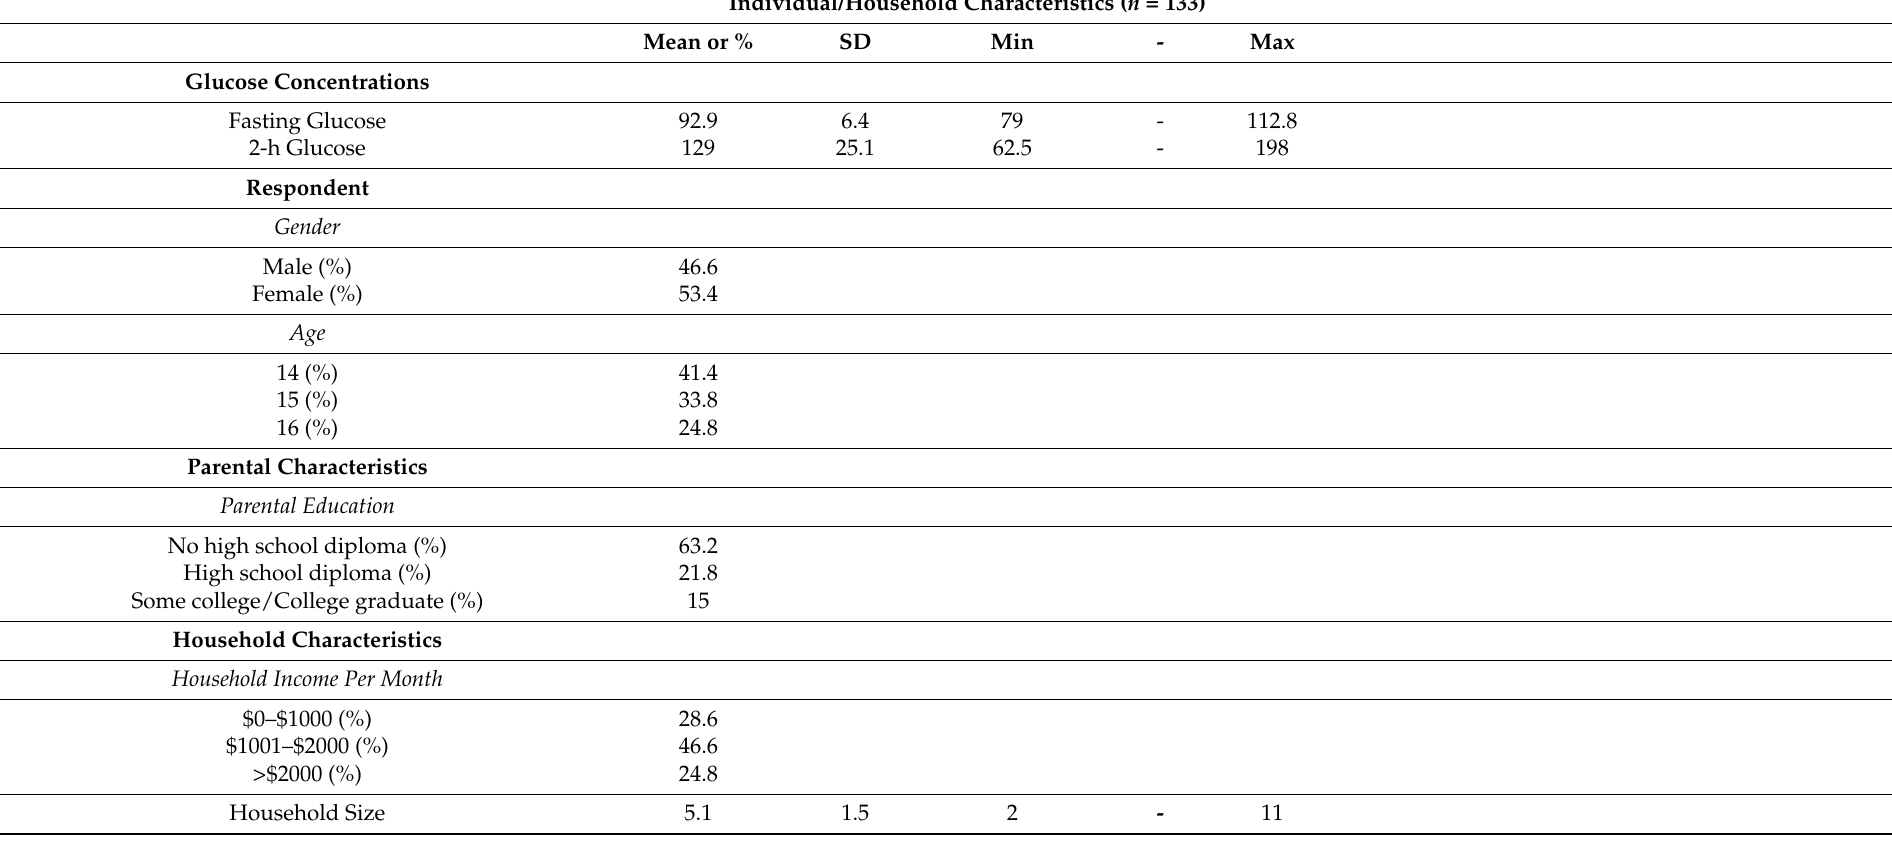
Table 1. Descriptive Statistics, Latino Youth in Phoenix with Obesity ( n = 133),